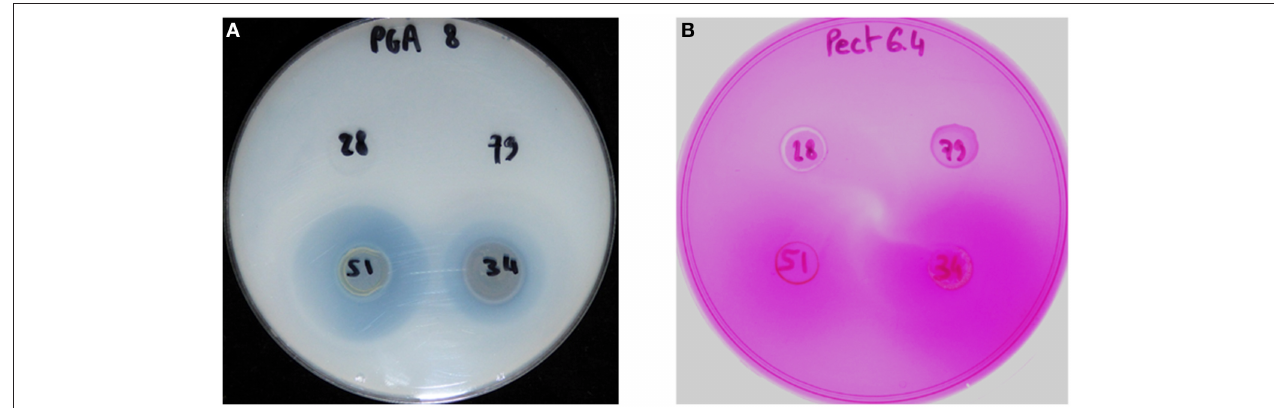
FIGURE 5 | Schematic representation of the T3SS locus of the four X. arboricola strains.